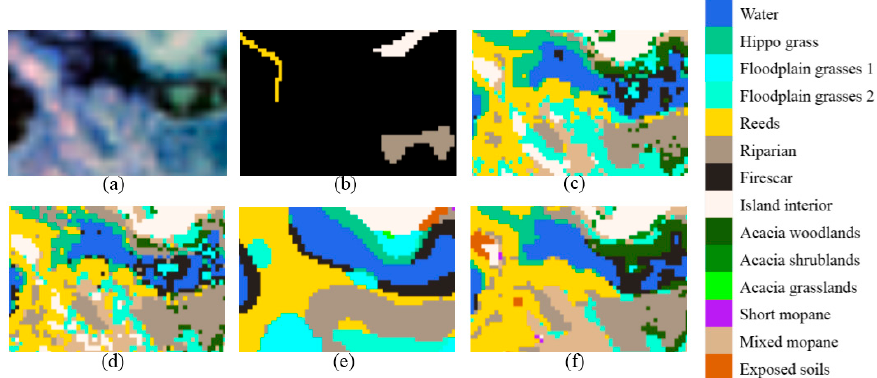
Figure 11. Zoom of classified region. ( a ) False-color composite. ( b ) Ground truth. ( c ) SAE-LR, OA = 98.49%. ( d ) DBN-LR, OA = 98.71%. ( e ) 2D-CNN, OA = 98.88%. ( f ) 3D-CNN, OA = 99.55%.